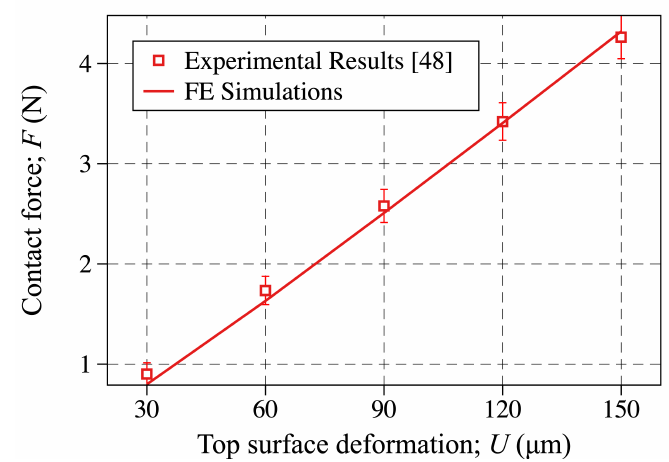
Figure 9. Probe contact force plotted against the top surface deformation obtained through experimental results reported in [48] (discrete points) and FE simulations carried out in this study (solid line). In obtaining the FE simulations the M-R material parameters obtained via the inverse analysis are